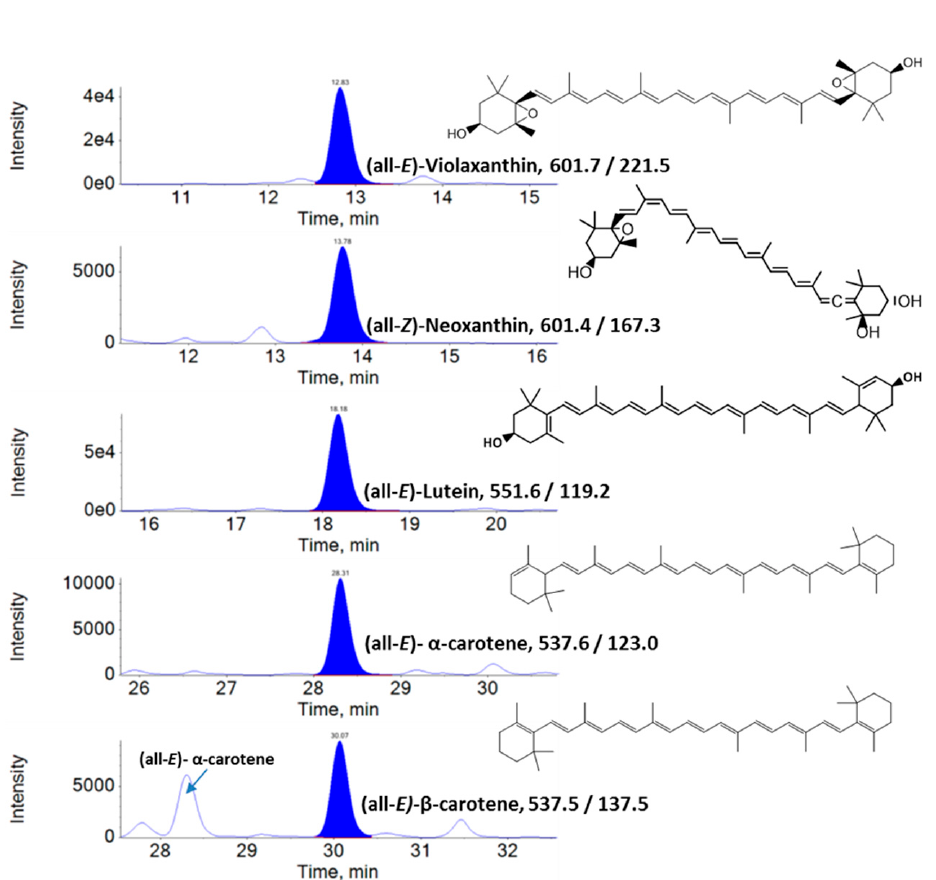
Figure 1. LC–MRM–MS chromatograms of carotenoids of KP-BG leaf extracts.